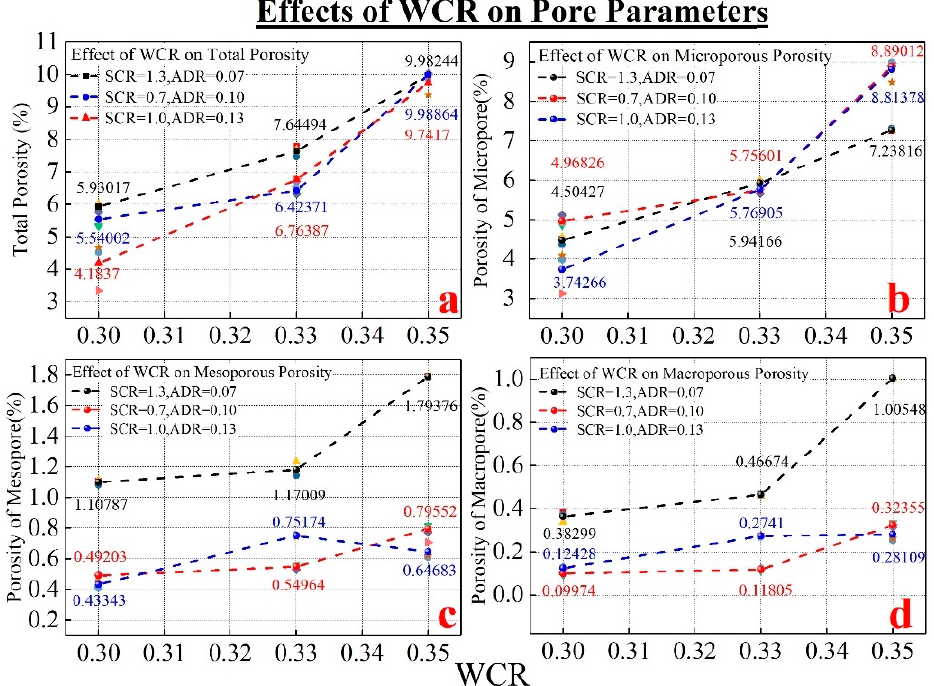
Figure 3. The influence of WCR on porosities of different radii. Figure ( a ) shows the effect of WCR on the porosity. Figure ( b ) shows the effect of WCR on the microporous porosity. Figure ( c ) shows the effect of WCR on the mesoporous porosity. Figure ( d ) shows the effect of WCR on the macroporous porosity.